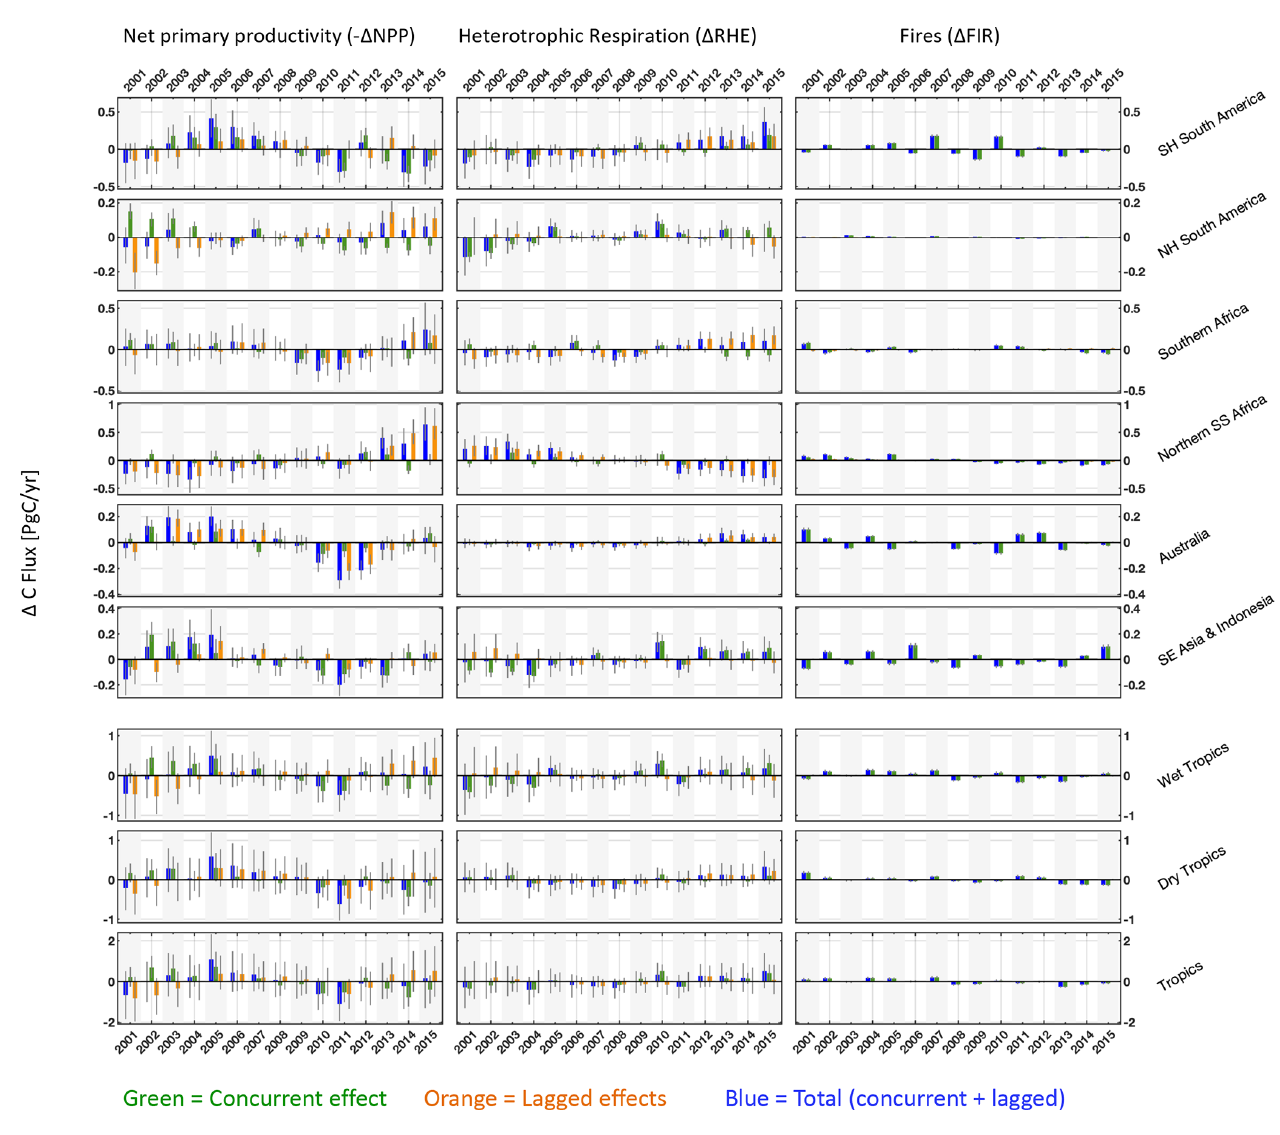
Figure 7. Regional and pan-tropical median annual net primary productivity (left column), heterotrophic respiration (centre column) and fire (right column) anomalies ( (cid:49) NPP, (cid:49) RHE and (cid:49) FIR, respectively). Blue bars represent total anomalies and green and orange bars represent the corresponding annual concurrent and lagged effects. (cid:49) NPP anomaly signs were reversed such that all anomalies are represented as positive for net land-to-atmosphere C flux. The sum of annual (cid:49) NPP, (cid:49) RHE and (cid:49) FIR is equivalent to annual (cid:49) NBE values presented in Fig. 6. Error bars denote the 25th–75th percentile uncertainty estimates for each flux